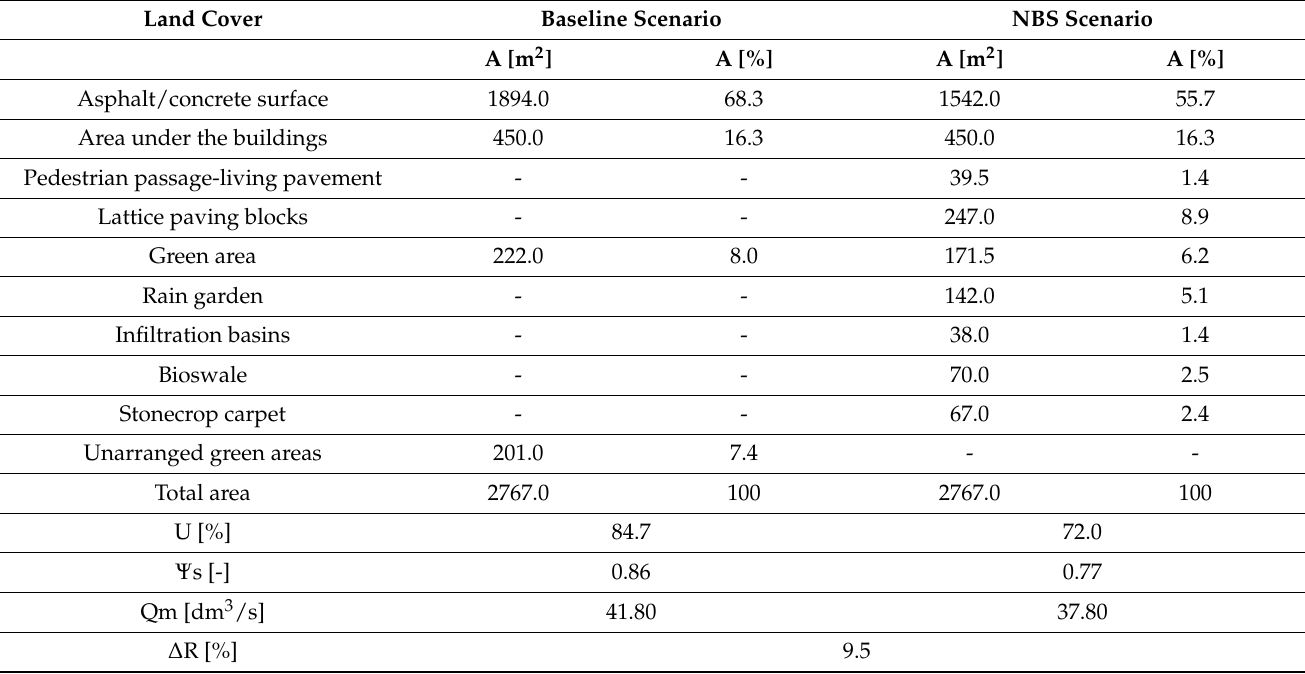
Table 8. Compilation of areas with different management techniques, reliable runoff of the rainwater Qm [dm 3 /s] before and after the design concept, and retention volume ∆ R